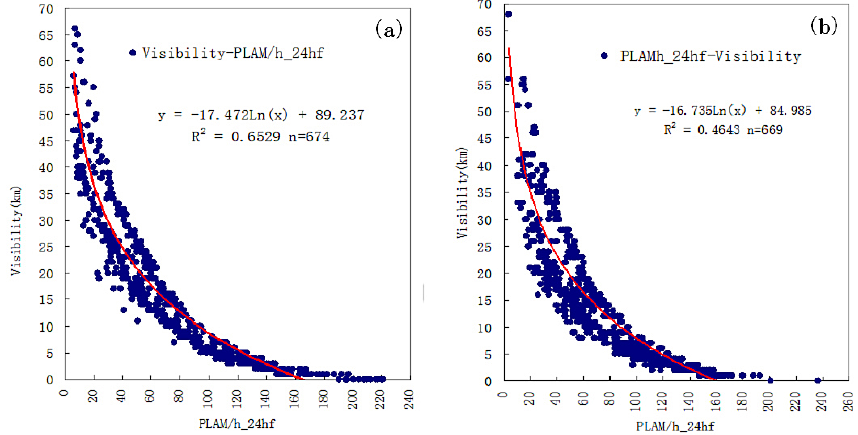
Figure 6. Correlation analysis results of PLAM/h index 24h forecasts and observed visibility at 08:00 (UTC + 8) on 20 February 2014 (a) and 08:00 (UTC + 8) on 22 February 2014 (b) .